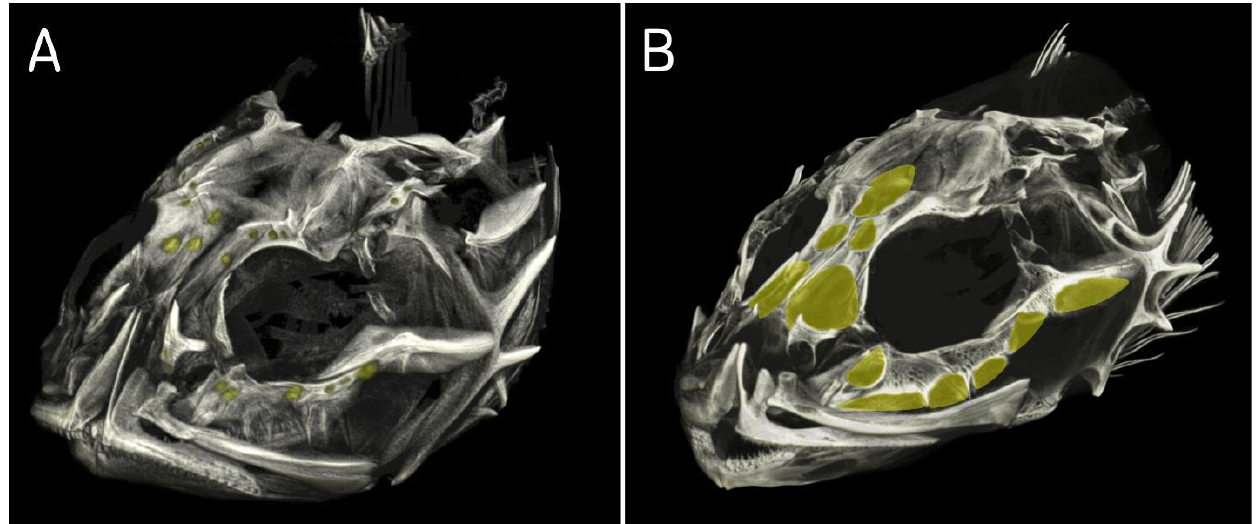
Figure 9. The tomograms of the skull: ( A ) M. stelleri , ZIN 50807, Bering Sea, Komandor Islands; ( B ) T. thompsonii , ZIN 21978, Lake Michigan.